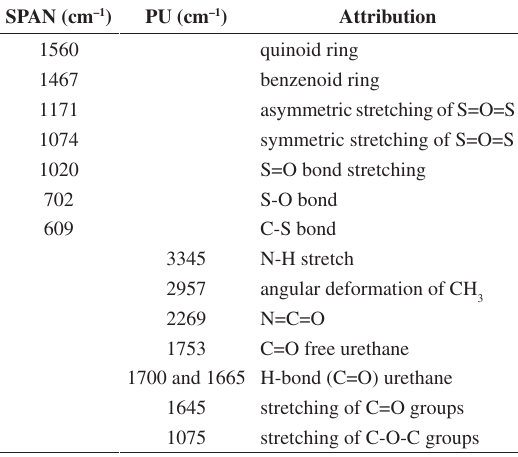
Table 2. FTIR attribution of the polymers